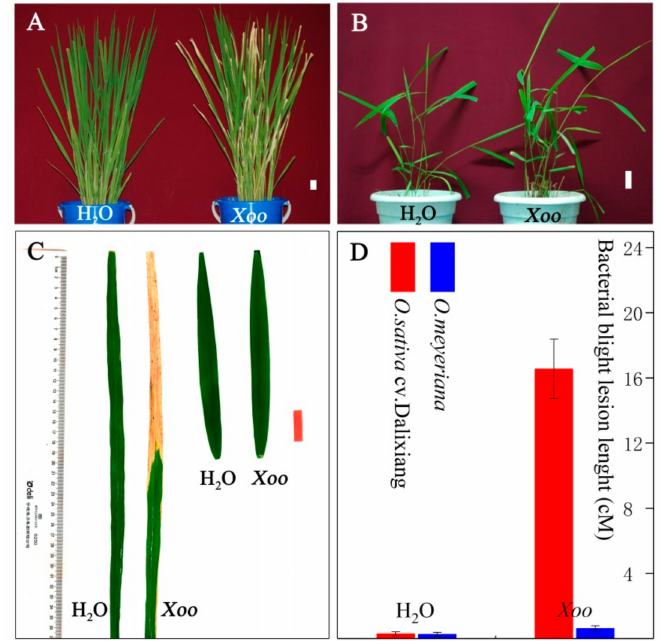
Figure 1. The high resistance of Oryza meyeriana to Xanthomonas oryzae pv. oryzae ( Xoo ). Rice was inoculated by the leaf-clipping method and at least 16 leaves from four plants were inoculated. Lesion length was measured three weeks after inoculation. ( A ) O. sativa ssp. japonica cv. Dalixiang. Left is plant inoculated with water (control) and right is plant inoculated with Xoo . White scale bar = 3 cm. ( B ) O. meyeriana . Left is plant inoculated with water and right is plant inoculated with Xoo . ( C ) Leaves inoculated with water and Xoo . Left is Dalixiang and right is O. meyeriana . Red scale bar = 3 cm. ( D ) Lesion length caused by Xoo infection. Bars indicate the standard